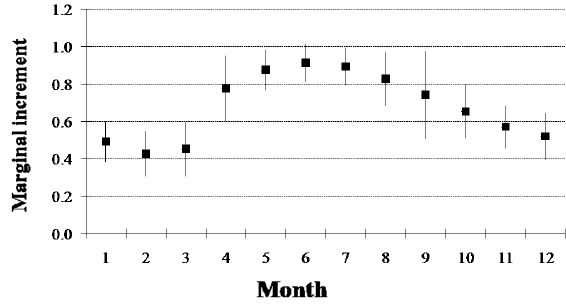
Fig . 6. – Monthly evolution of marginal increment analysis (MiA) in sectioned otoliths of Aphanopus carbo from mainland Portugal.